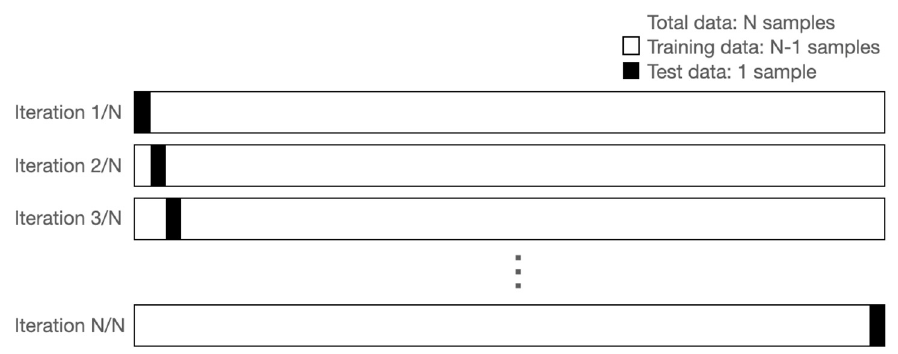
Figure 1. Leave-one-out cross validation.